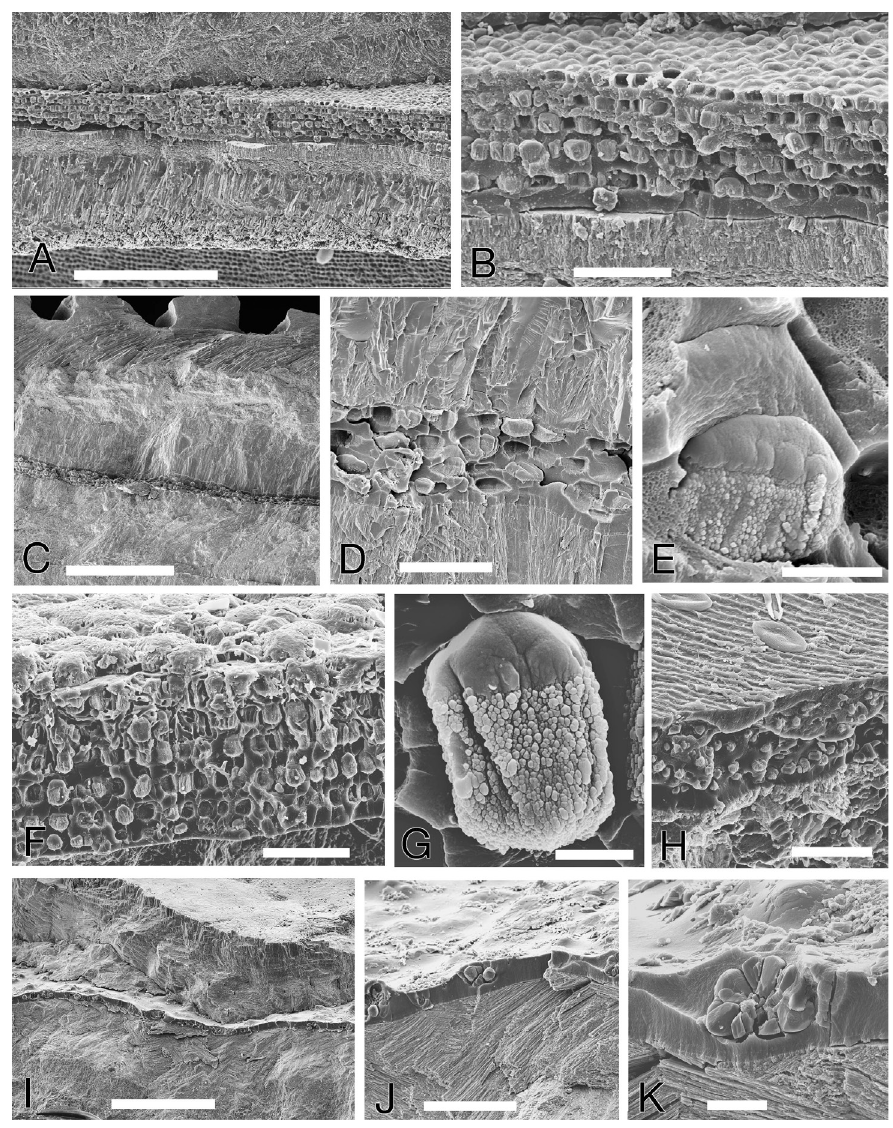
Figure 6. Shell microstructure of other species Pleurolucina hendersoni , P. undata , Lucina pensylvanica and Cardiolucina quadrata . A Pleurolucina hendersoni Guadeloupe, fractured section with prominent cal- cified conchiolin layer, periostracum at base. Scale bar = 20 µm B P. hendersoni , detail of conchiolin layer with lines of calcareous spherulites. Scale bar = 20 µm C Pleurolucina undata Baja California, fractured section with thin conchiolin layer Scale bar = 200 µm D P. undata , detail of conchiolin layer with spheru- lites. Scale bar = 20 µm E P. undata , single spherulites embedded in conchiolin. Scale bar = 3 µm F Lucina pensylvanica Florida Keys, calcified conchiolin layer. Scale bar = 20 µm G L. pensylvanica , single spheru- lite. Scale bar = 2 µm H L. pensylvanica , section of periostracum with calcareous granules. Shell interior to top. Scale bar = 20 µm I Cardiolucina quadrata Philippines, fractured section with conchiolin layer. Scale bar = 200 µm J C. quadrata detail of conchiolin layer with calcareous aggregates. Scale bar = 50 µm K C. quadrata detail of calcareous aggregate. Scale bar =10